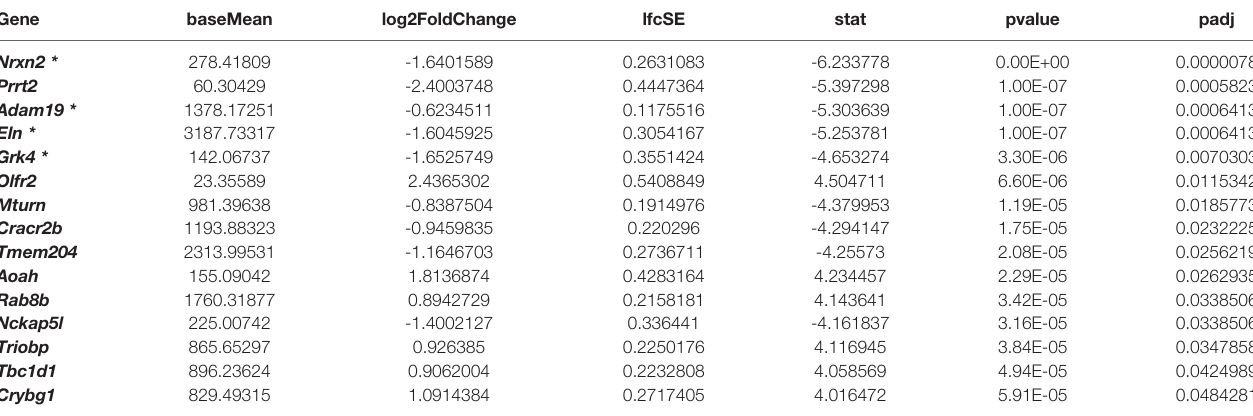
LungsandbloodwereharvestedfrommicechallengedwithTIGR4pneumococcus24p.i.Genesymbolswithasterisksindicatetranscriptsup-regulatedinPuma +/+ anddown-regulatedin Puma -/- . a = 0.05.